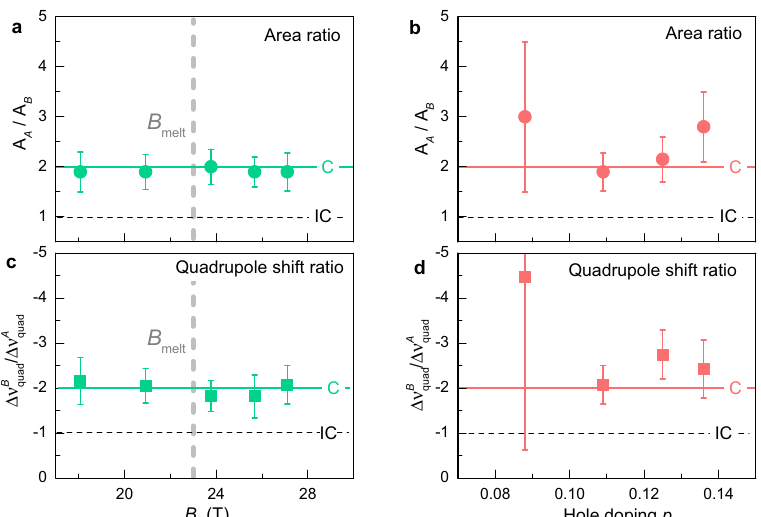
Fig. 4 Quantitative support to the period-3 commensurate case. a , c Field dependence of the area ratio and quadrupole shift ratio of the two peaks of the O(2) site obtained from fi tting full spectra (4 quadrupole satellites), for the hole doping p = 0.109. b , d Doping dependence of the area ratio and quadrupole shift ratio at high fi elds (exact fi eld values depend on sample, see Supplementary Fig. 6). Large error bars of the sample with p = 0.088 result from broad O(2) satellites due to necessarily imperfect O-II chain order at this doping. The continuous lines correspond to the expectation for a commensurate modulation (C) of period 3, the horizontal dashed lines correspond to the expectation for an incommensurate modulation (IC). These dashes also correspond to the expectation for a commensurate period 4, provided the phase is such that the line shape shows only two peaks, as in Supplementary Fig. 2 (panels e, j, o). Thick vertical dashed lines in ( a ) and ( c ) mark the vortex melting fi eld at 2 K, B melt ~ 23T, which is in principle close to B c 2 = B melt ( T = 0